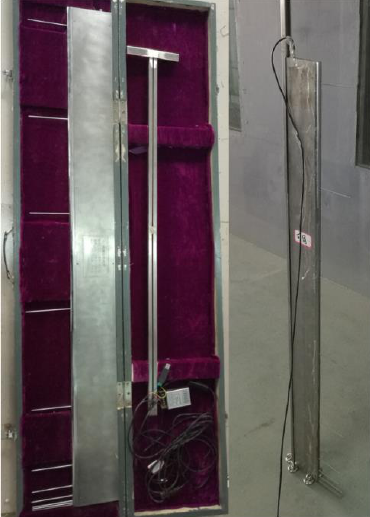
Figure 3. The wind profiler.